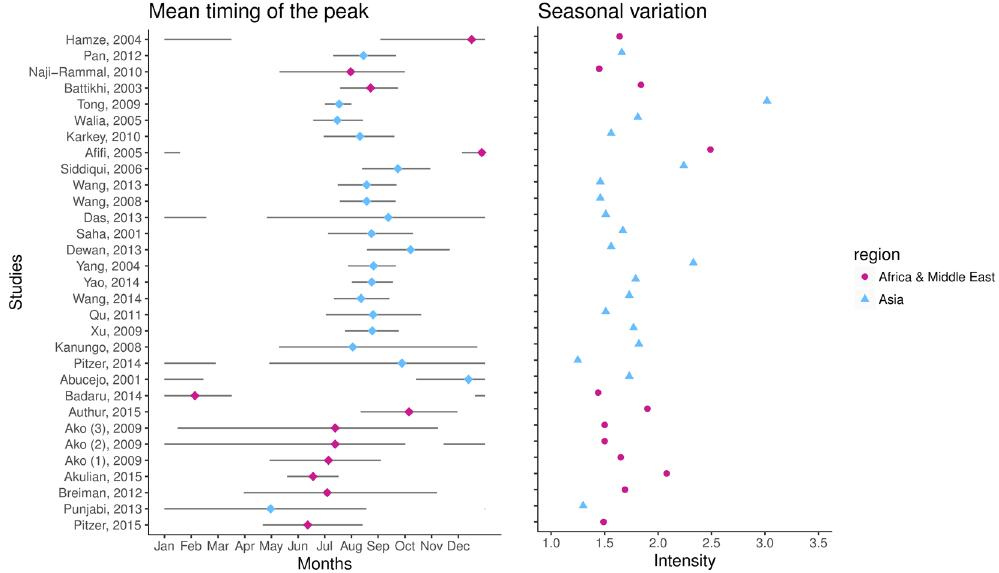
Figure 3. Mean timing of the peak and seasonal variation for contemporary ( > 1990) data on enteric and typhoid fever. Mean timing (as measured by center of gravity) is represented by the colored dots, while the lines represent the corresponding 95% confidence intervals. The seasonal variation is quantified by the seasonal intensity (peak/mean). Studies are ordered by latitude, from North (top) to South (bottom) and colored by region: Africa & Middle East (Purple) and Asia